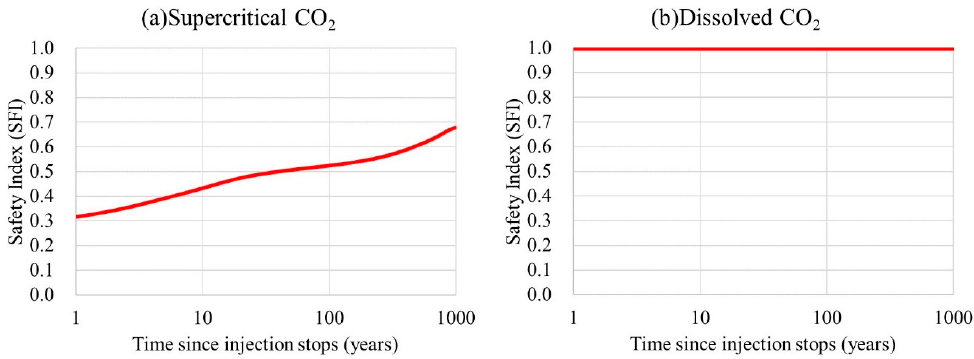
Figure 18. Comparison of the safety index ( SFI ) calculations between the two scenarios.